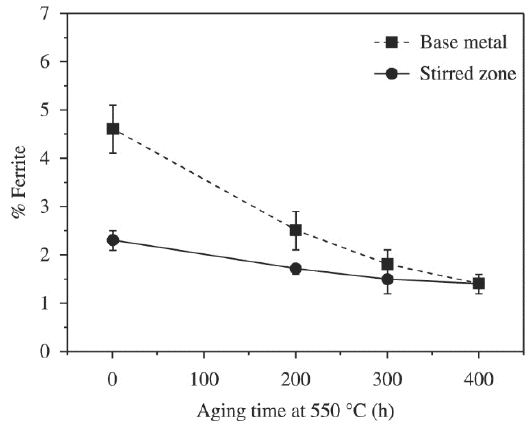
Figure 6. Variation of the amount of ferrite with aging time at 550 °C.